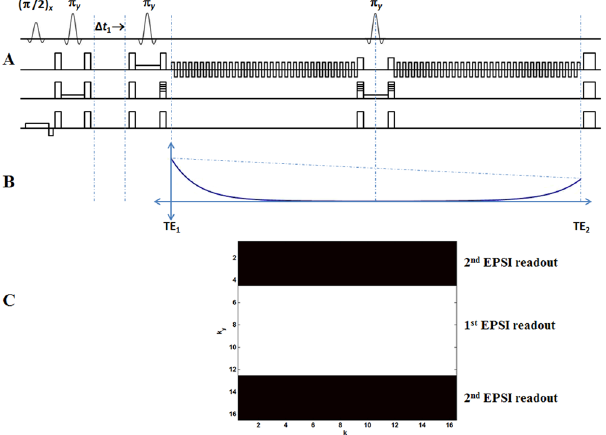
Figure 1. ( A ) A schematic diagram of the PRESS-based ME-EP-JRESI sequence, showing the three localization pulses and two echo-planar readouts separated by a slice selective 180° pulse; ( B ) shows the effect of the spin echo on the overall shape of the signal envelope, where the solid line represents the T 2 * decay and the dashed line represents the decay due to T 2 ; ( C ) shows the k -space acquisition by the two EPSI